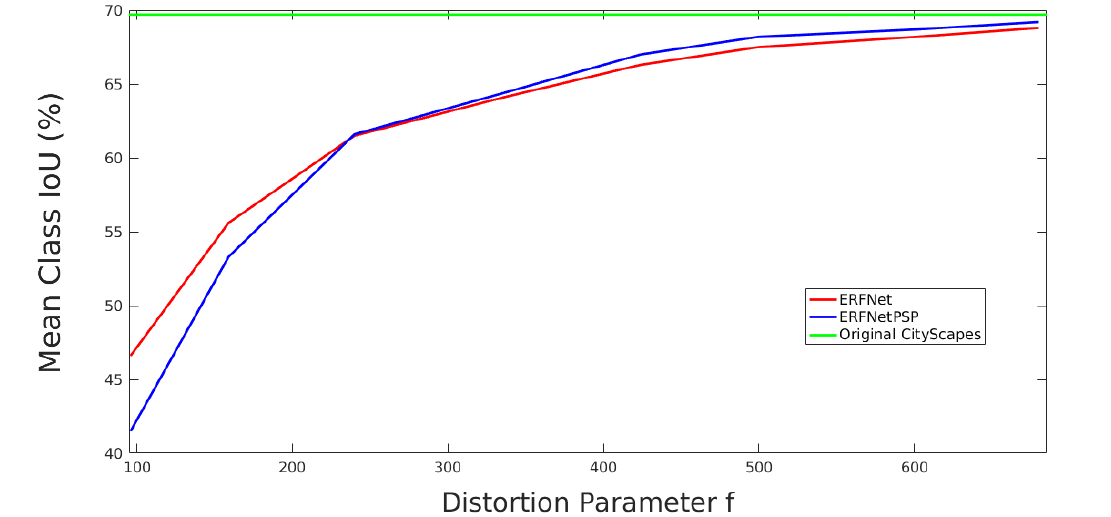
Figure 9. Mean class IoU performance vs. level of added distortion for basic training.